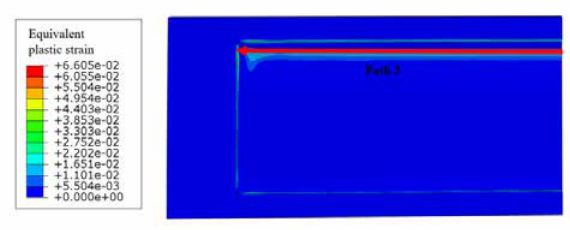
Figure 16: The contour plot of equivalent plastic strains on the 98 th day